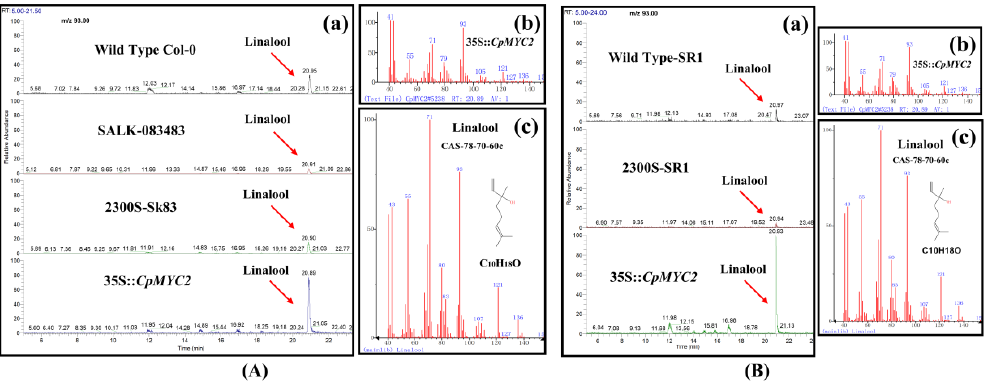
Figure 7. GC-MS analysis of linalool emitted from the flowers of ( A ) arabidopsis wild type (WT-Col-0), mutant Salk-083483, transformed by the empty vector pCAMBIA2300S (2300S-Sk83) and overexpressed CpMYC2 gene (35S:: CpMYC2 ) plants, and ( B ) tobacco wild type SR1, transformed by the empty vector pCAMBIA2300S (2300S-SR1) and overexpressed CpMYC2 gene (35S:: CpMYC2 ) plants. (a) GC-MS chromatogram comparison between different plants. (b) Mass spectrum of the product. (c) Product confirmation in the NIST database according to retention index and mass spectrum.